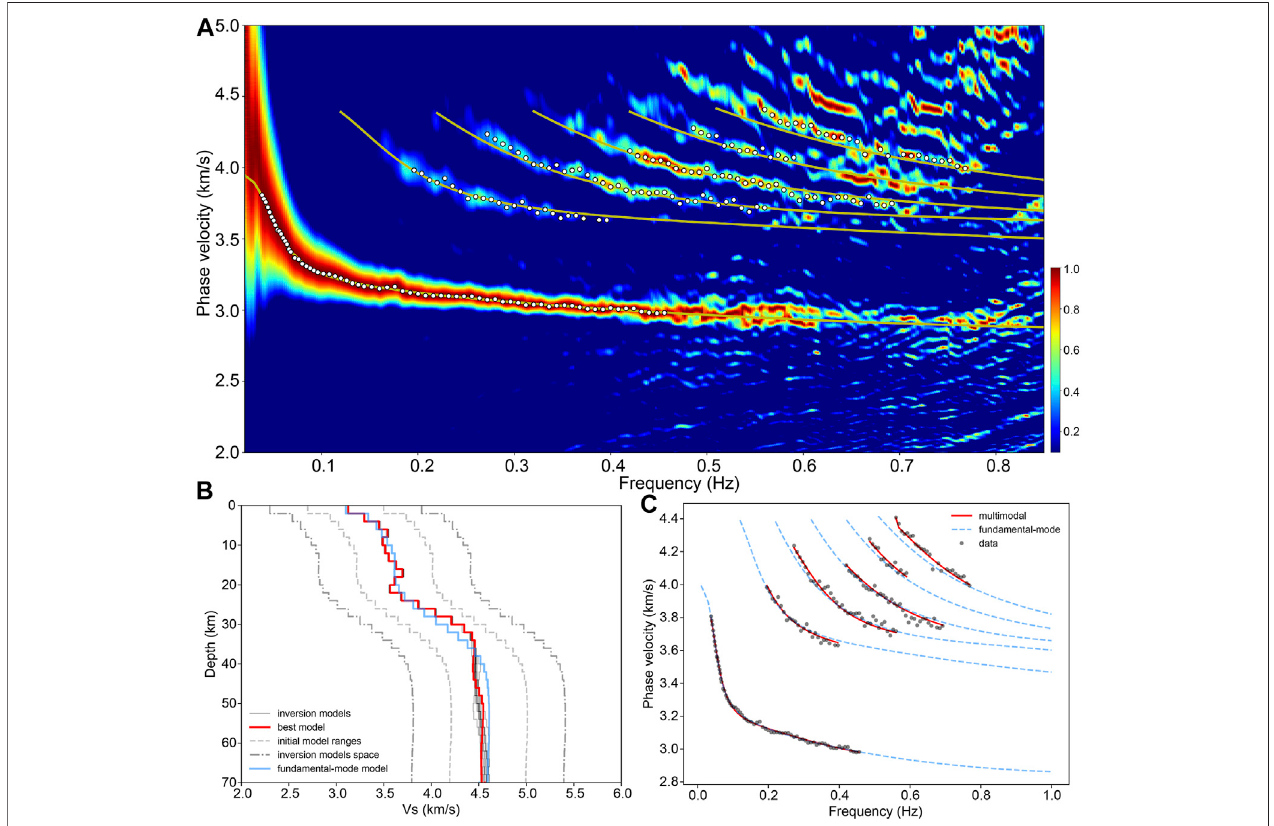
FIGURE10| Identi fi cationofthemultimodaldispersioncurvesofsubarray2andtheinversionand fi ttingresults. (A) TheF-Jspectrogramofseismicarray “ subarray 2 ” . (B) and (C) The inversion and fi tting results of the multimodal dispersion curves.